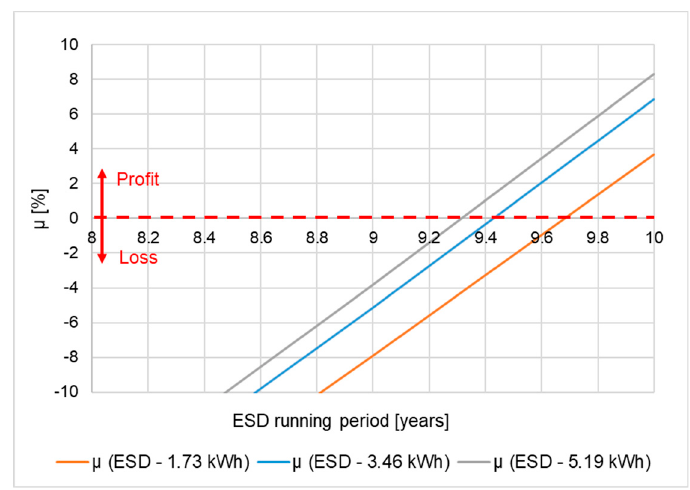
Figure 9. Economic efficiency optimization parameter.